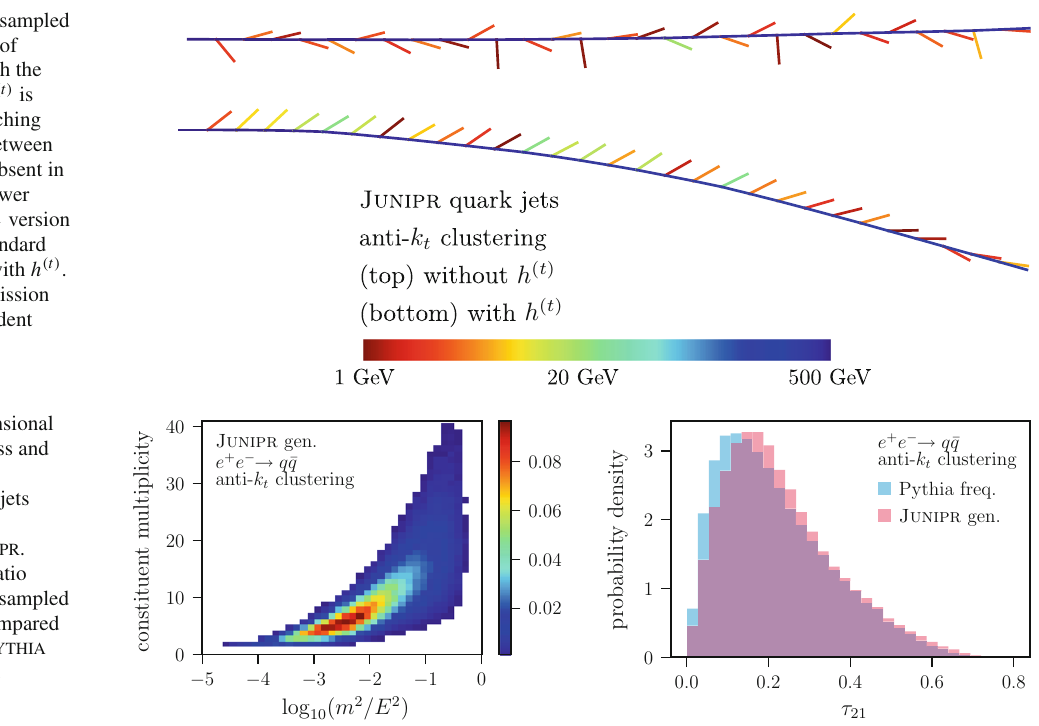
Pythia freq. Junipr